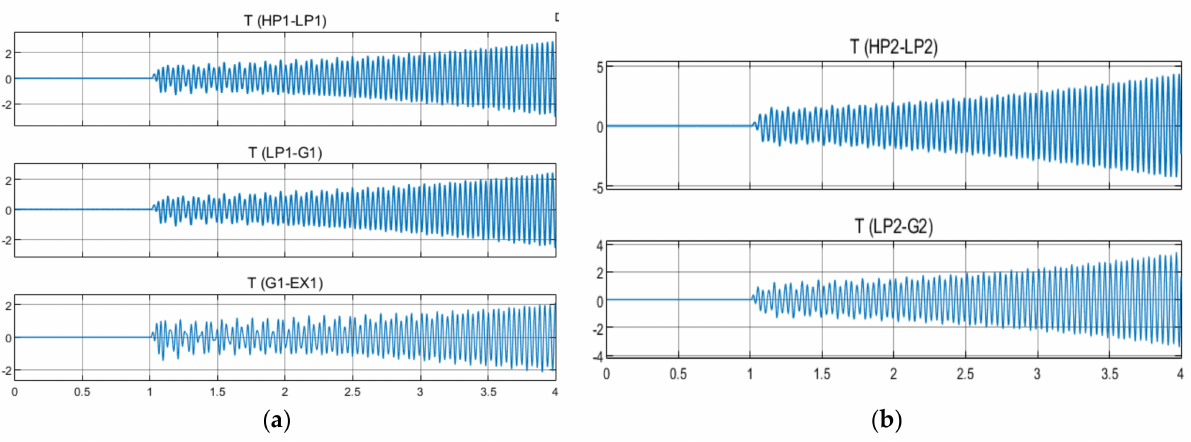
Figure 8. ( a ) Torque T (HP1-LP1), T (LP1-G1), and T (G1-EX1) in the steam turbine of G1; ( b ) torque T (HP2-LP2) and T (LP2-G2) in the steam turbine of G2 without